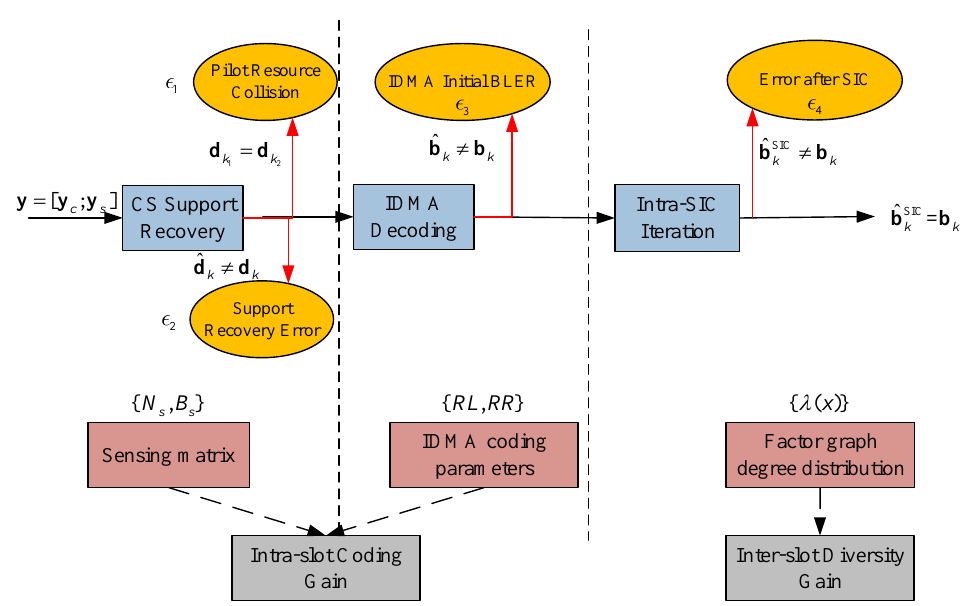
Figure 5. The system-level packet loss broken down into module-level error events, with the corre- sponding coding parameters and coding